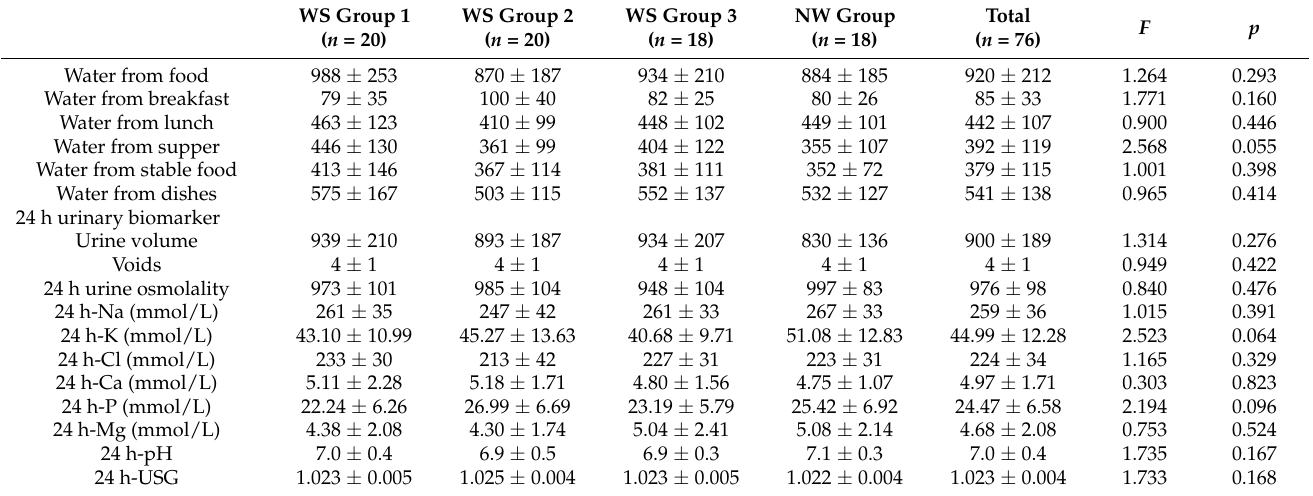
Table 3. The water from food and 24 h urinary biomarkers of participants during the 24 h water